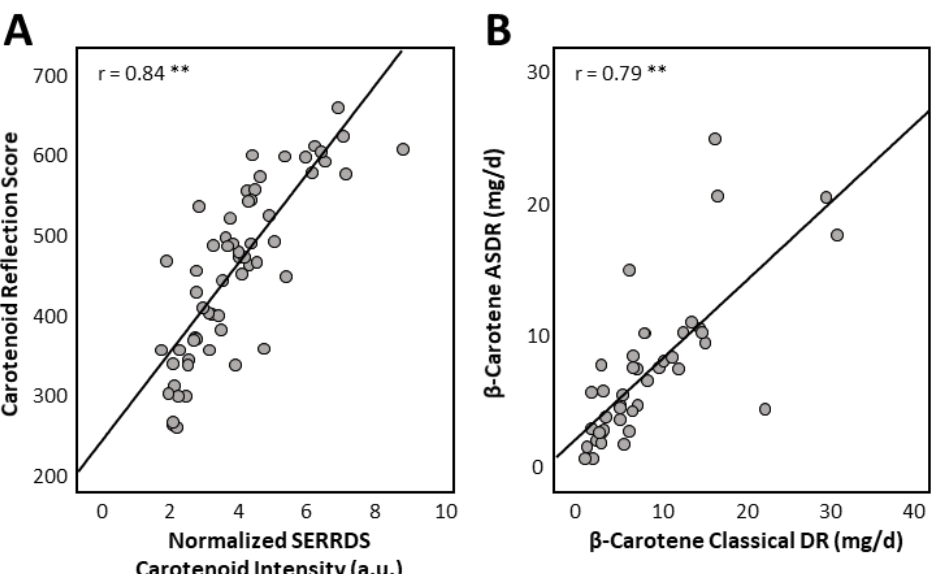
Figure 2. ( A ) Correlation between skin carotenoid measurements performed with Raman and reflection spectroscopy from 21 subjects assessed at three visits ( n = 63). ( B ) Correlation between intake-data for β -carotene assessed using app-based short dietary record and classical 3-day dietary record ( n = 42). Displayed Pearson correlation coefficients were calculated from transformed data. ** p < 0.0001. Table 3. Correlations between specific plasma carotenoids from week 4 and week 8 with their respective skin levels from week 4 and week 8 and intake data from weeks 1–4 and weeks 5–8 ( n = 42).